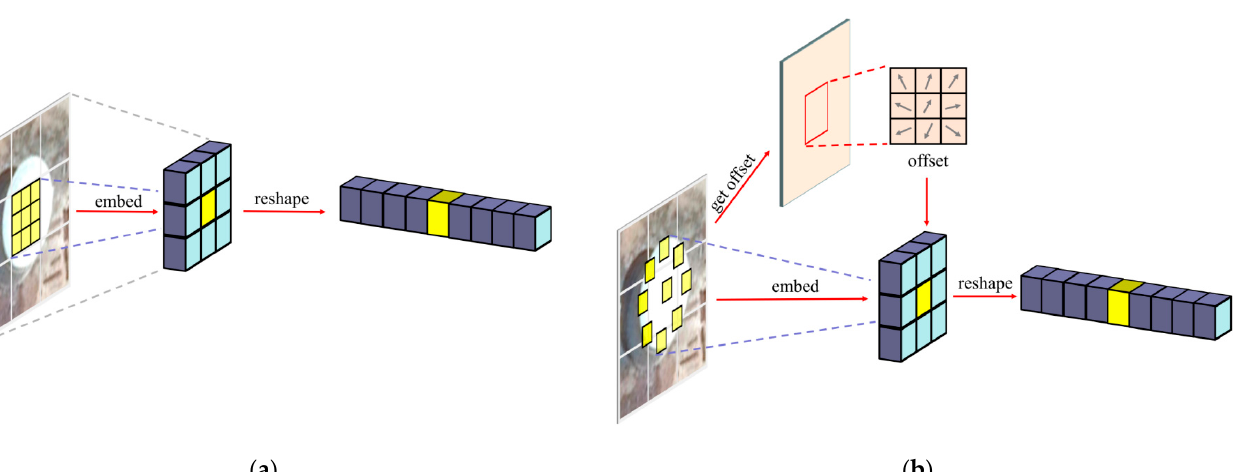
the ground-truth boxes are represented by the blue lines. Some targets’ semantics are compromised.